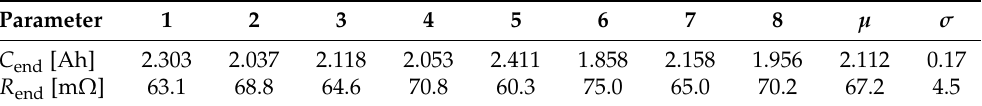
Table 2. Capacities and internal resistances of the 8 cells used in the experiment after aging.